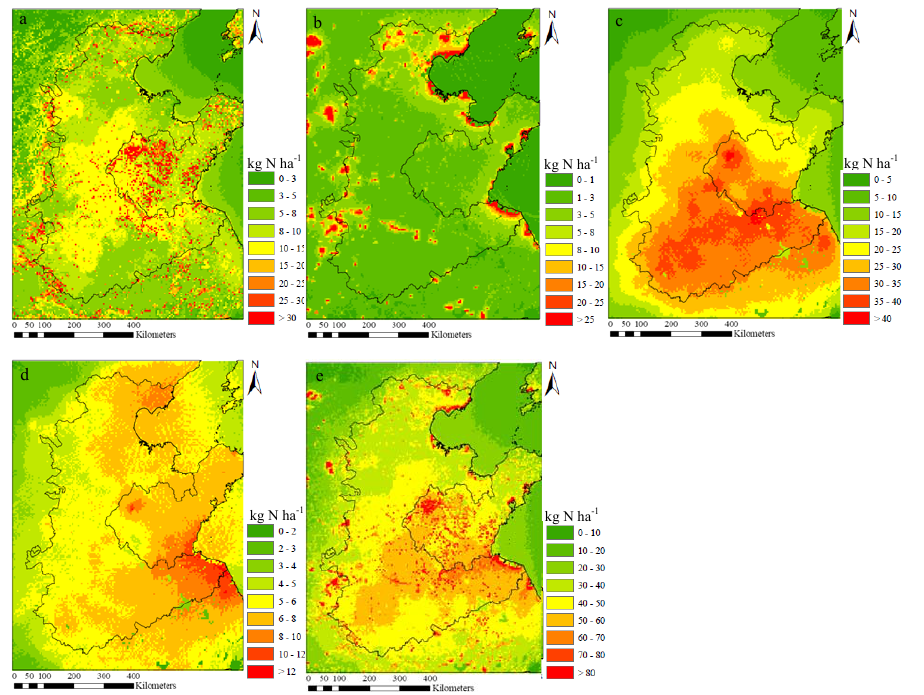
Fig. 7. Modeled deposition of N-containing pollutants in the NCP in 2008 at 5 × 5km 2 resolution (a. NH x -dry; b. NO y -dry; c. NH x -wet; Figure 7. Modeled deposition of N-containing pollutants in the NCP in 2008 at 5×5 km 2 resolution (a. NH x -dry; b. NO y -dry; c. d. NO y -wet; e. NH x -wet; d. NO y -wet; e. N-total).